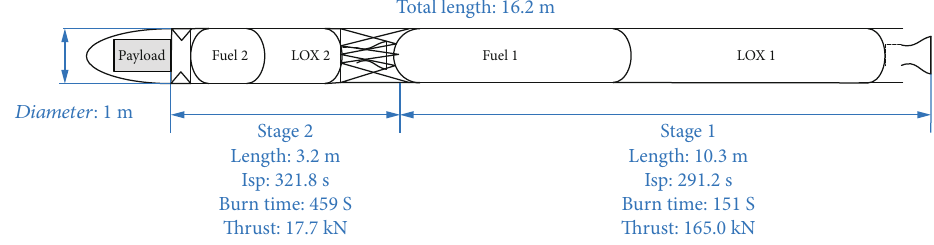
Figure 13: Geometry con fi guration of the miniature